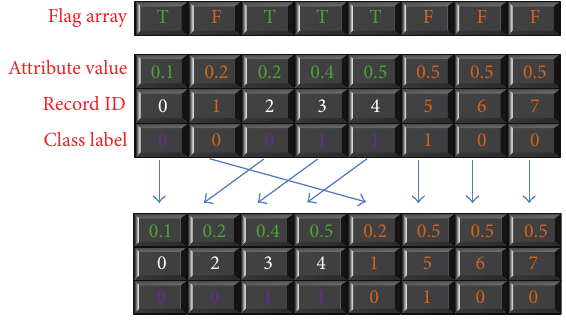
Figure 11: Example of split attribute lists.